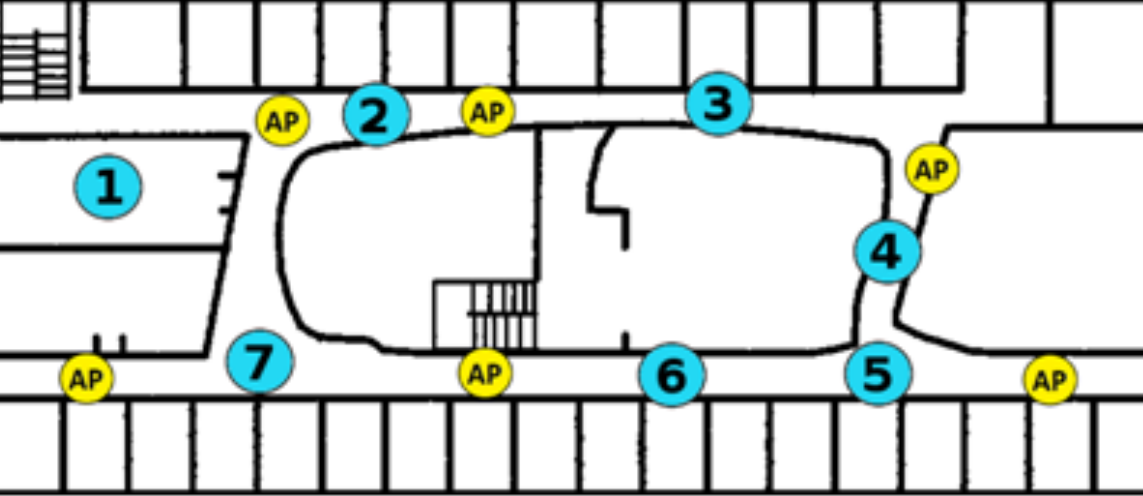
Figure 4. Map of the testing area with Wi-Fi access points (AP) and the estimated measuring locations (1-7)